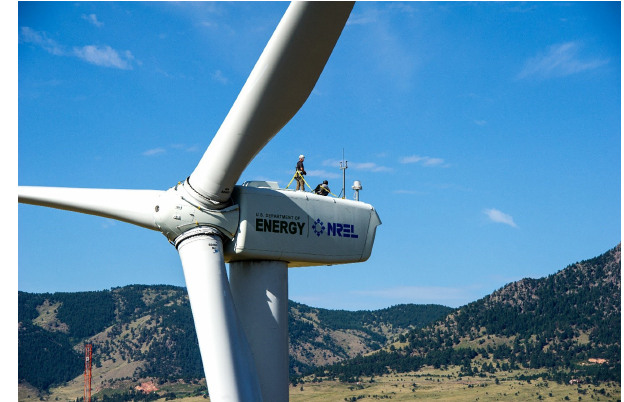
Figure 1. GE 1.5/77sle turbine at the National Wind Technology Center. Photo credit: Dennis Schroeder, NREL (image gallery num- ber